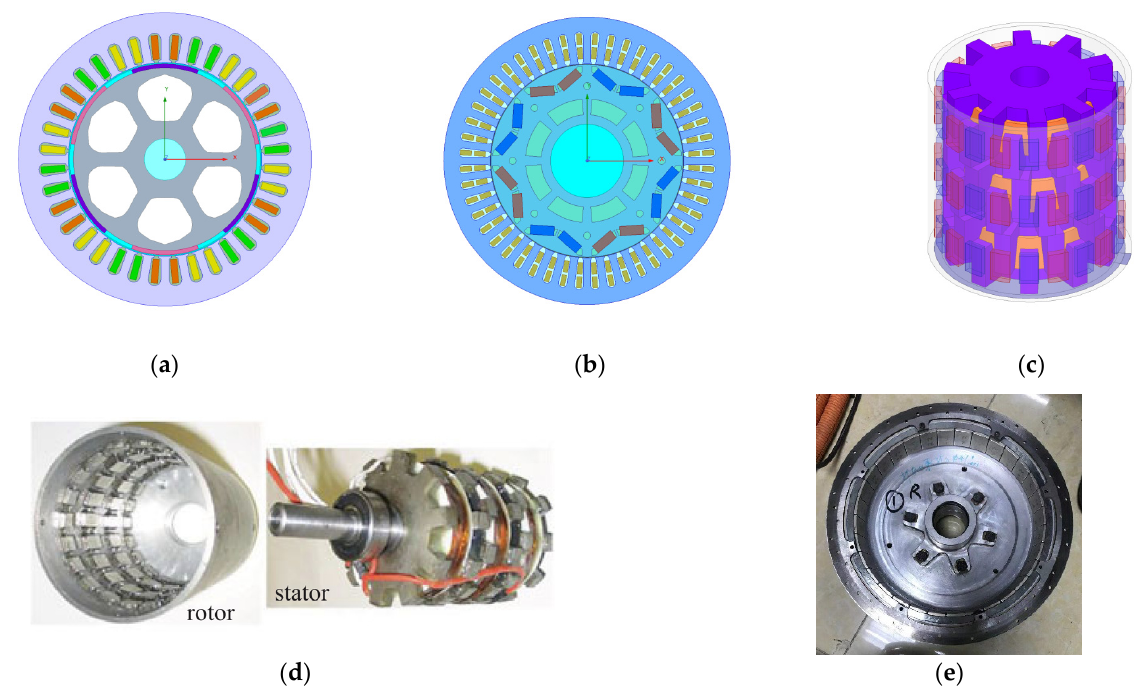
Figure 1. Prototypes of the PMSM: ( a ) surface-mounted PMSM; ( b ) interior PMSM; ( c ) claw-pole PMSM; ( d ) transverse flux PMSM; ( e ) axial flux PMSM.